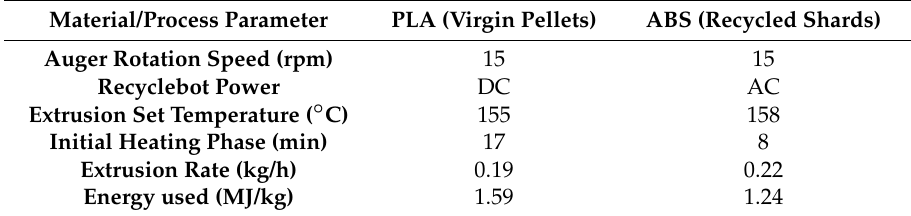
Table 7. Recyclebot process parameters and results comparing the filament manufacturing of PLA pellets and ABS recycled